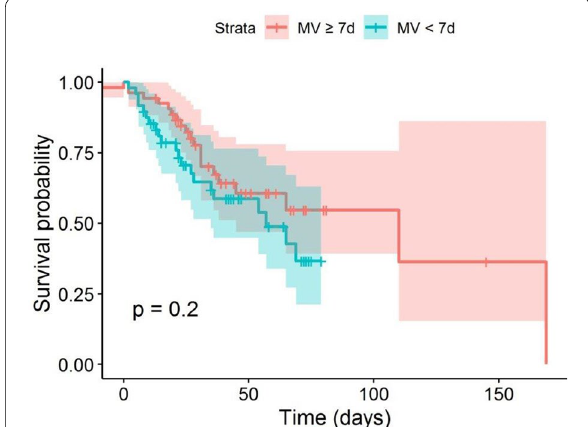
Fig. 1 Survival probabilities plotted for all patients grouped by